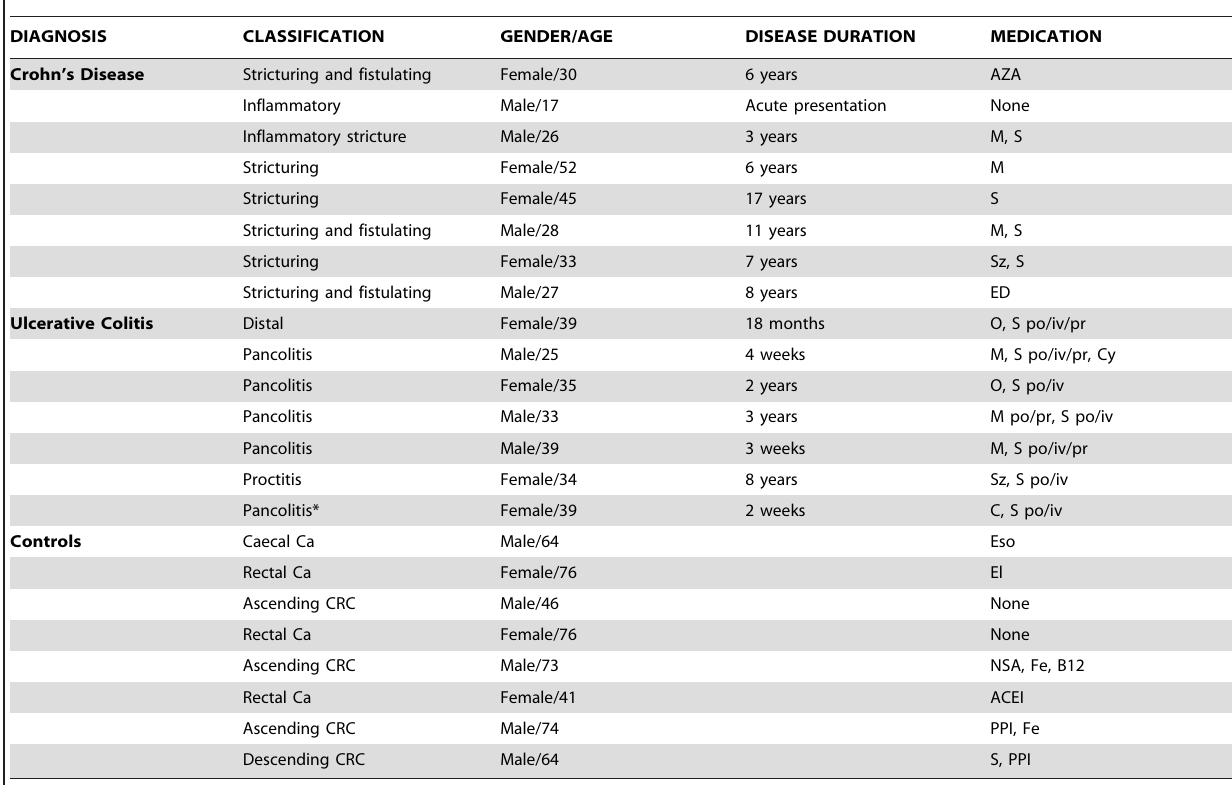
This table outlines the demographics of the patients with refractory IBD and control patients used in this study. *Multiple Sclerosis for years; CRC – colorectal carcinoma; po – per oral; pr – per rectum; iv – intravenously; AZA – Azathioprine; M – Mesalazine; S – Steroids; Sz – Salazopyrine; ED – Elemental Diet; O – Olsalazine; C – Cyclophosphamide; Cy – Cyclosporin; Eso – Esomeprazole; El – Eltroxin; PPI – proton pump inhibitor; Fe – iron supplements; NSA – nuseals aspirin; ACEI – angiotensin converting enzyme